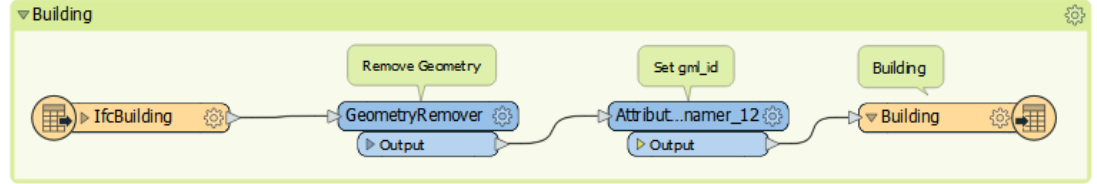
Figure 14. Conversion to remove geometry from “IfcBuilding”.